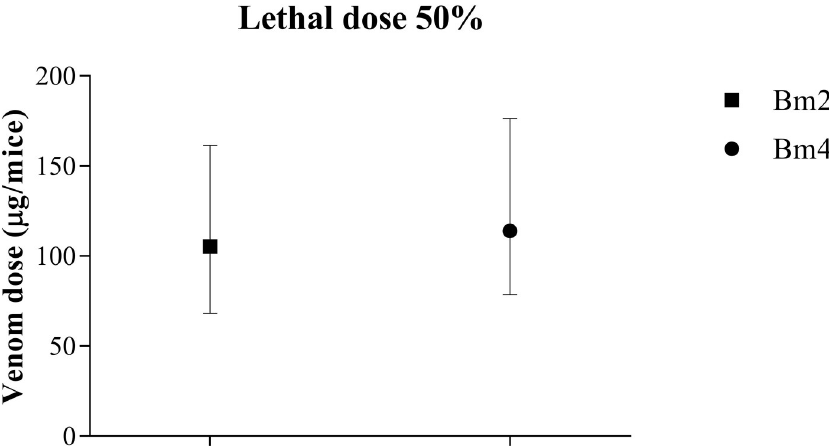
Fig 10. Lethal dose (LD 50 ) of two individual venoms of B . moojeni snakes. The LD 50 was determined by the intraperitoneal injection of different doses of B . moojeni venom belonging to the Bm2 and Bm4 individuals. Median lethal dose (LD 50 ) is defined as the dose responsible for the death of 50% of the population analyzed.